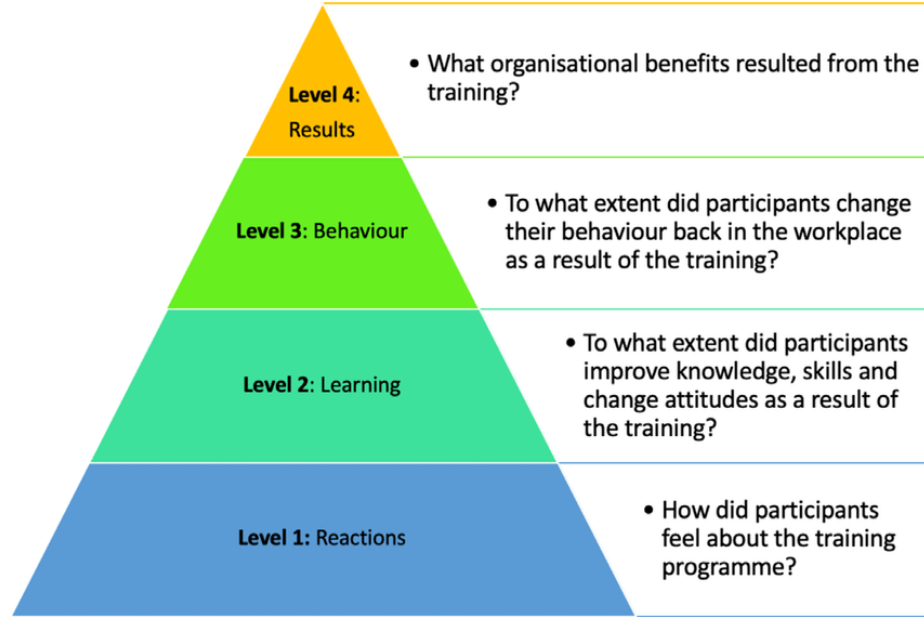
Figure 2. The Kirkpatrick four-level evaluation model [30].